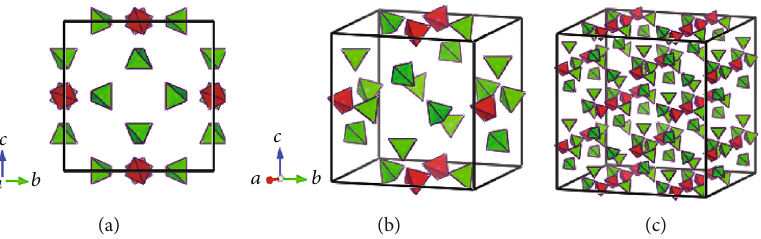
Figure 5: The location of M molecules in the Zif-8 compound. (a) Top view of unit cell. (b) Crystal shape view of unit cell. (c) Crystal shape of 2 × 2 × 2 super cell. Table 4: Total and formation energies of M +Zif-8 compounds.